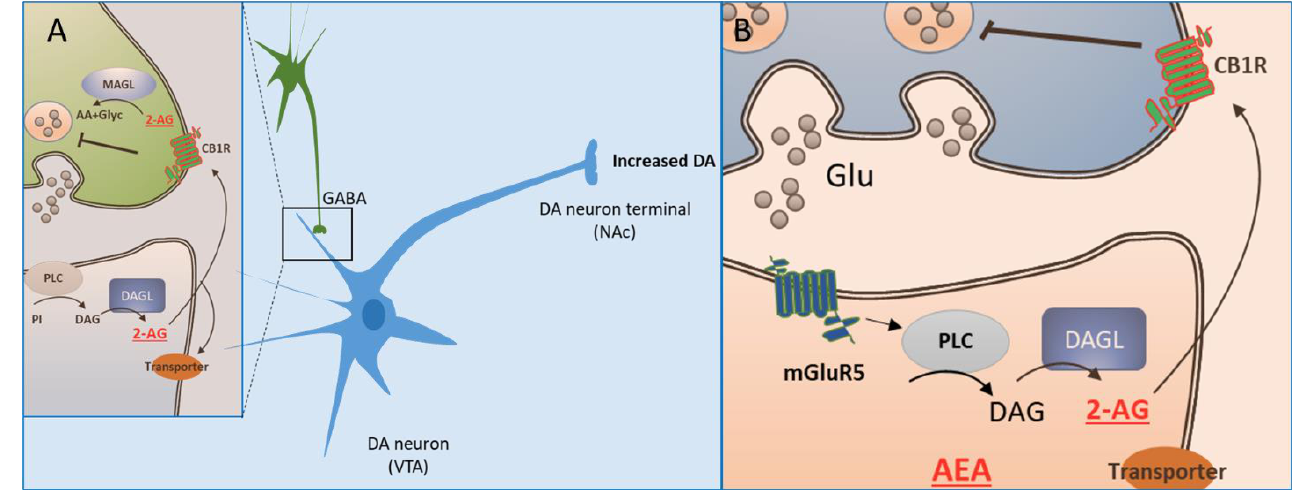
Figure 2. Modulation of neuronal activity by the endocannabinoid system. Endocannabinoids modulate neuronal activity as illustrated for dopamine (DA) neurons with cell bodies in the ventral tegmental area (VTA). CB1 receptors on GABAergic terminals ( A ) can facilitate dopaminergic activity through suppression of the inhibitory input onto the GABA receptors present on DA neurons, leading to an increase of DA release. Further, the activation of mGluR5 receptor by released glutamate ( B ) leads to the synthesis and release of 2-arachidonoylglycerol (2-AG), which then retrogradely activates CB1 receptors to inhibit additional glutamate release.